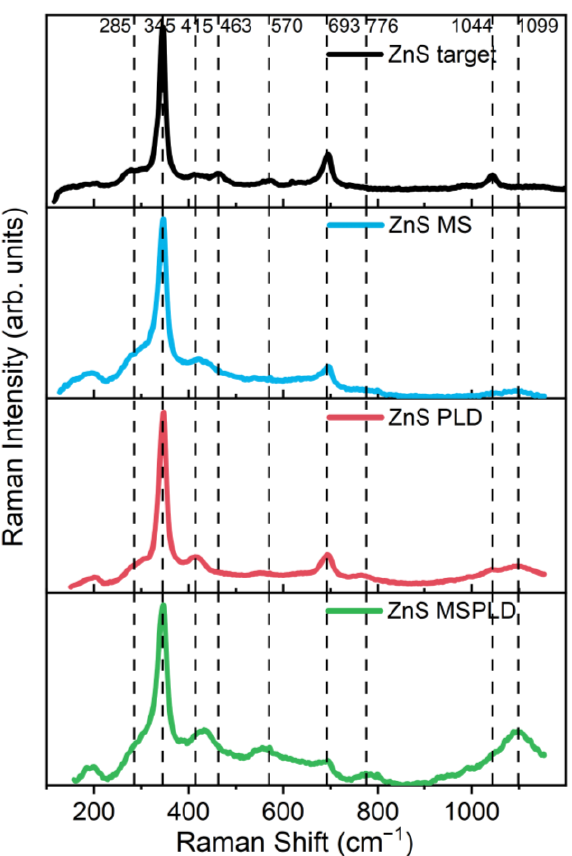
Figure 2. Raman spectra, at λ = 325 nm laser excitation, of the ZnS samples deposited by MS, PLD, and MSPLD, after annealing. The spectrum for the ZnS target is shown for comparison.